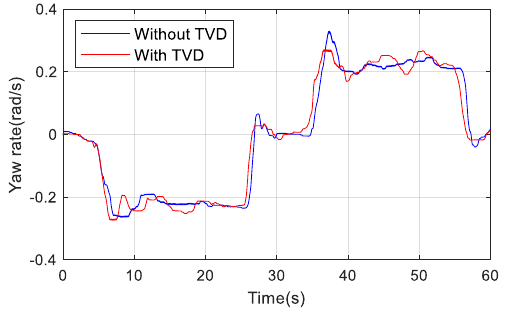
Figure 12. Curves of yaw rate.